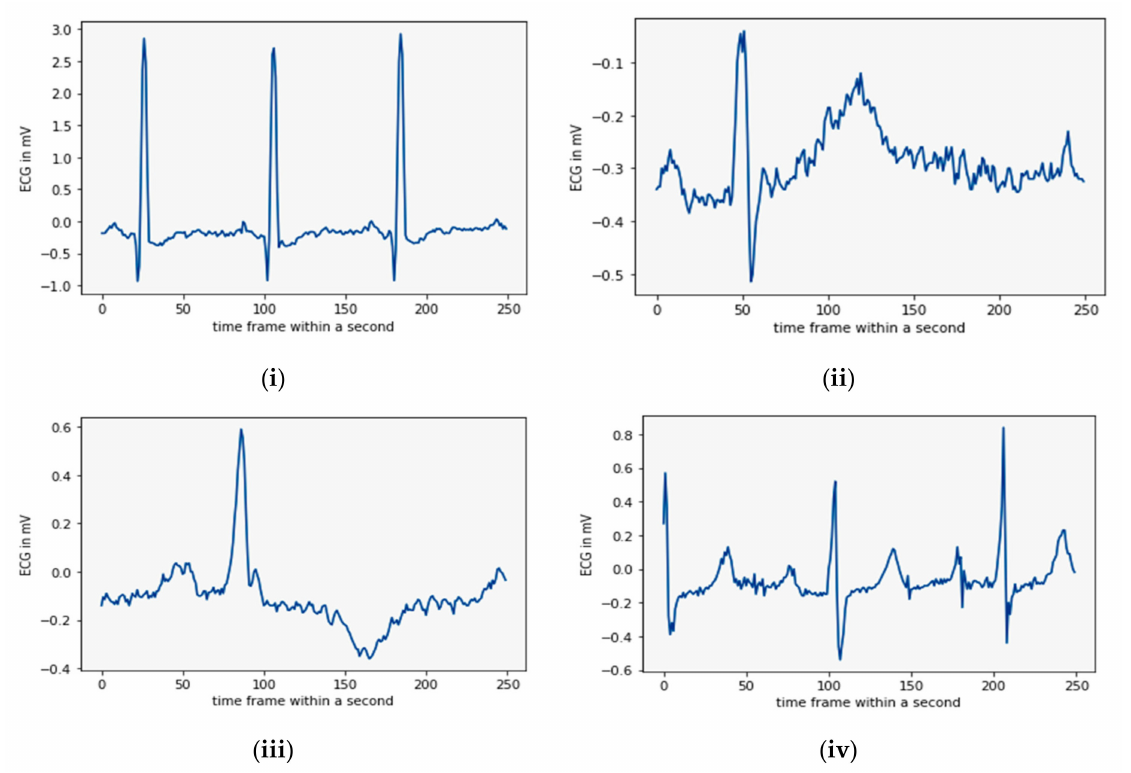
Figure 1. A set of four sample rhythms: ( i ) NSR, ( ii ) AFIB, ( iii ) MVE, and ( iv ) SVA (from